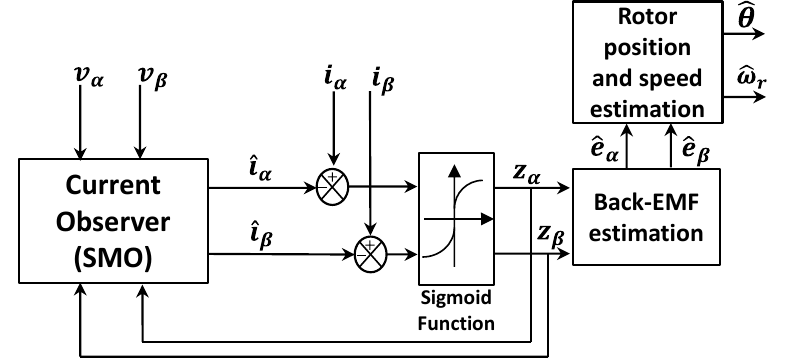
Figure 4. Block diagram of SMO for the sensorless control.